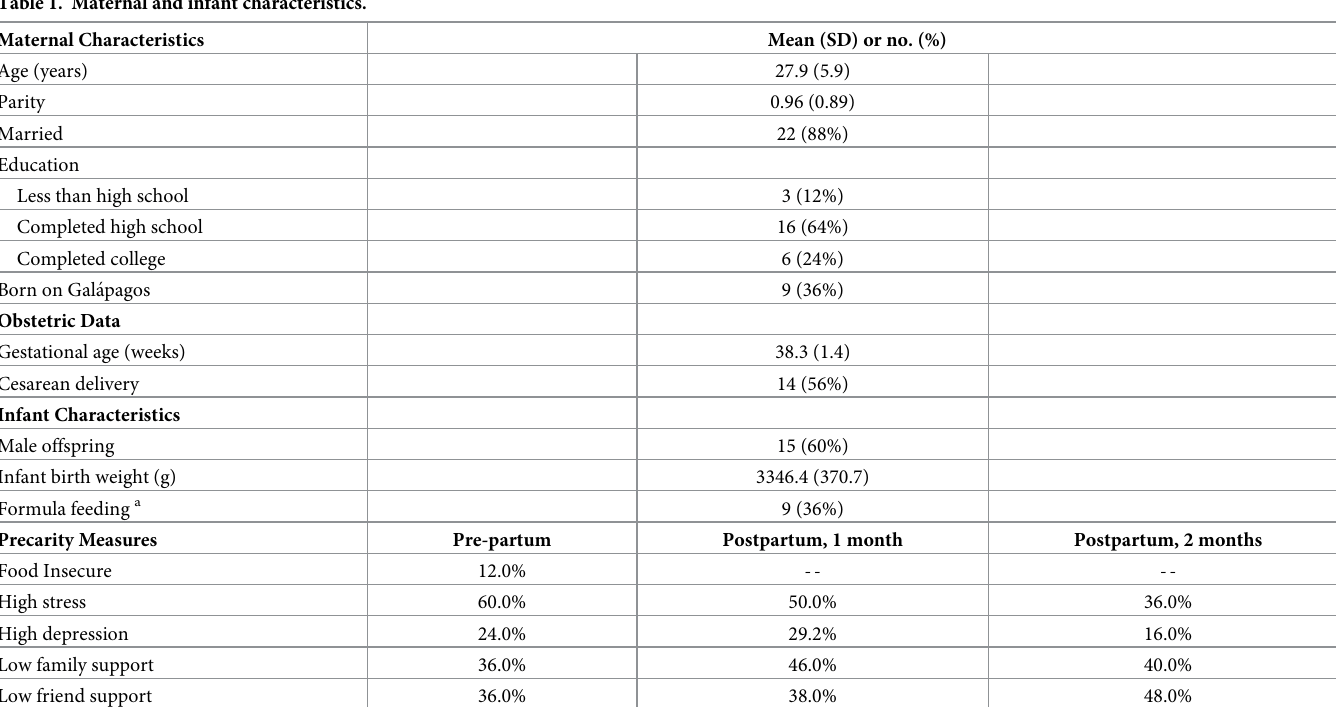
Table 1. Maternal and infant